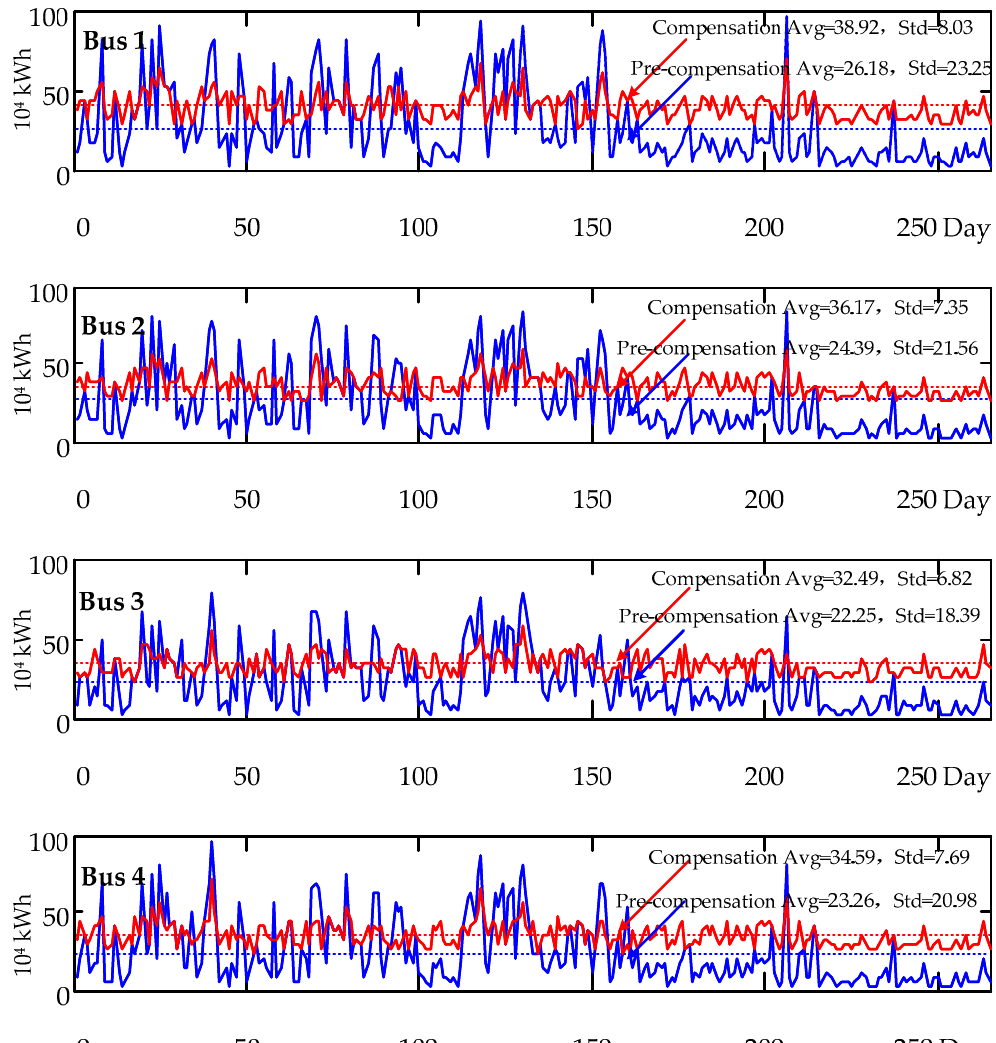
Figure 15. P R > 2Avg ( P R ) battery charging, P R < Avg ( P R ) battery Figure 15 . P R > 2Avg ( P R ) battery charging ， P R < Avg ( P R ) battery discharging.